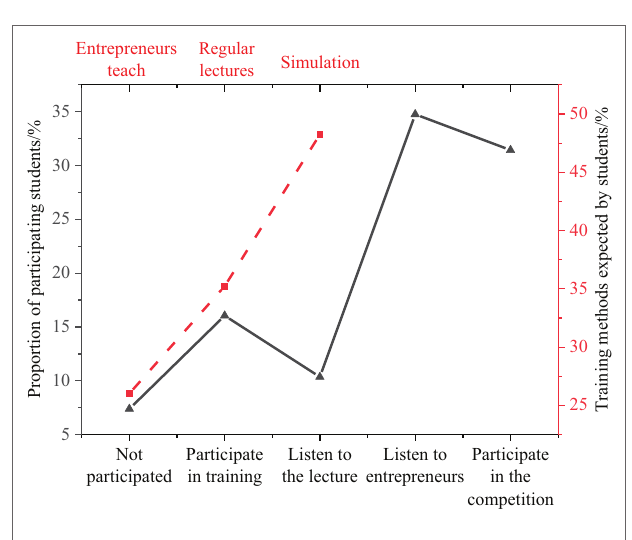
FIGURE 9 | College students’ participation in innovation and entrepreneurship courses.